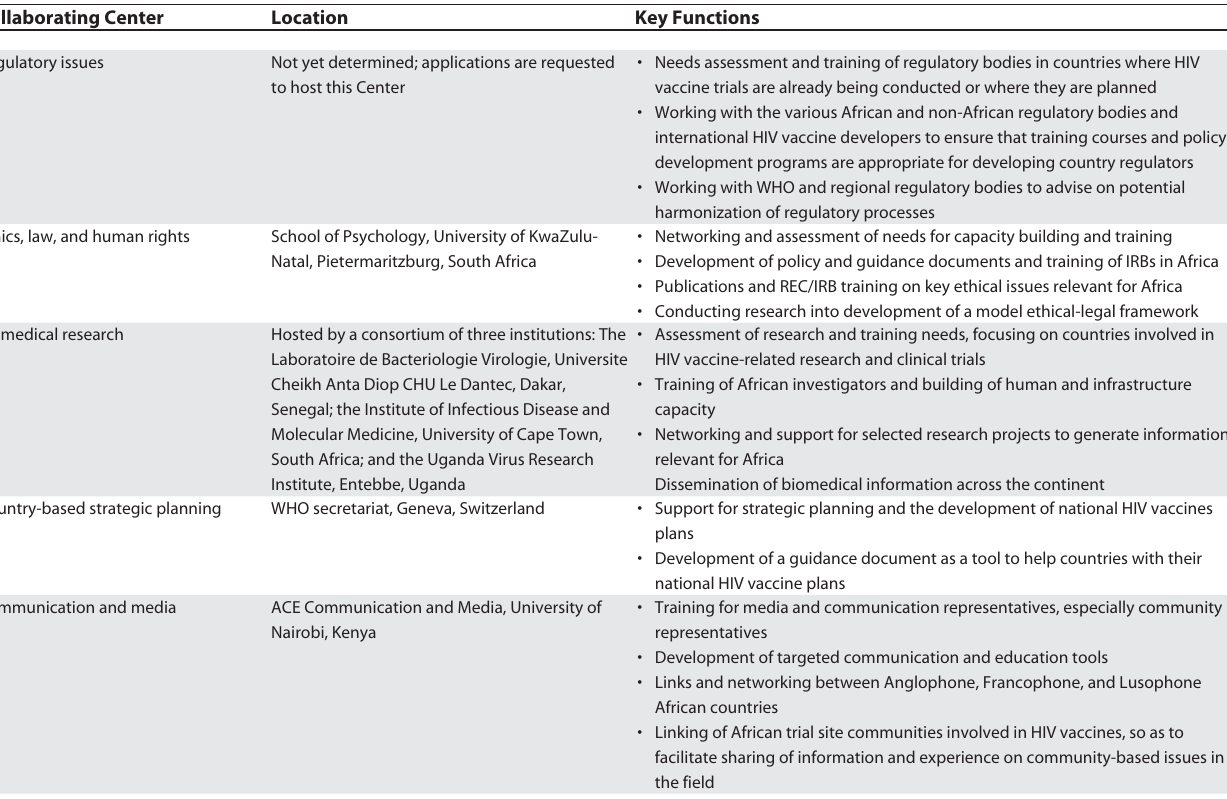
Table 1. AAVP Collaborating Centers, Location, and Key Functions Collaborating